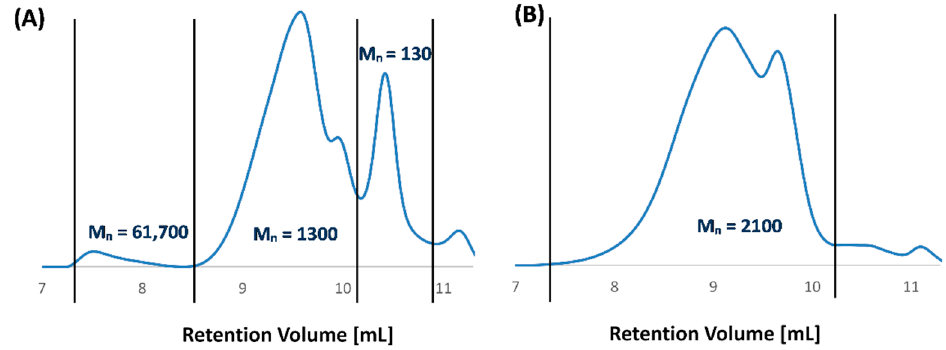
Figure 3. Gel-permeation chromatography (GPC) chromatograms of polyDBB_PEG_250_60 ( A ) and polyDBB_PEG_600_60 ( B ).